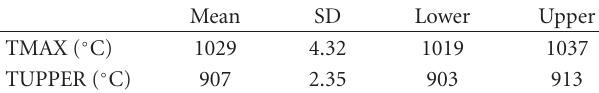
Figure 15: RMPS reference case—maximum temperature in the core region distribution. Table 3: Results for the RMPS reference